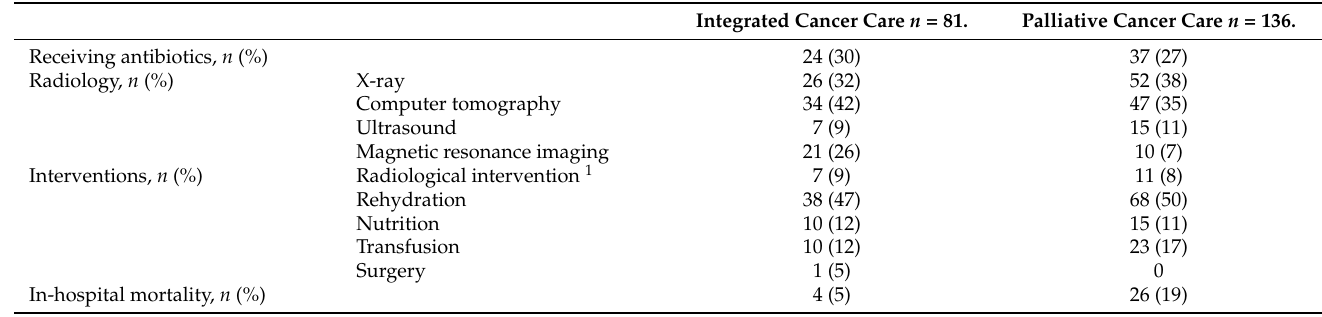
Table A3. Characteristics of integrated cancer care ( n = 81) and palliative care cancer patients ( n = 136). Two missing (information not